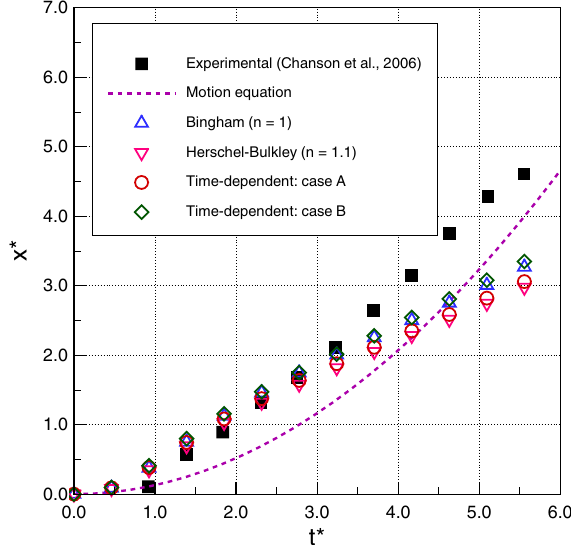
Figure 9. Thixotropic avalanche case 3: comparison of numerical results and experimental data for non-dimensional front displace- ment ( x ∗ ) as a function of non-dimensional simulation time ( t ∗